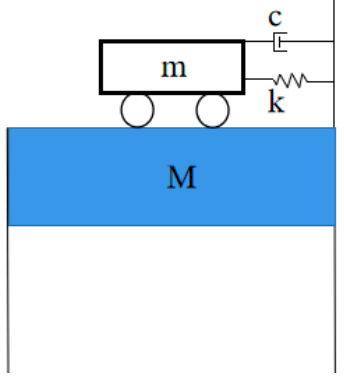
Figure 5. TMD structure diagram.